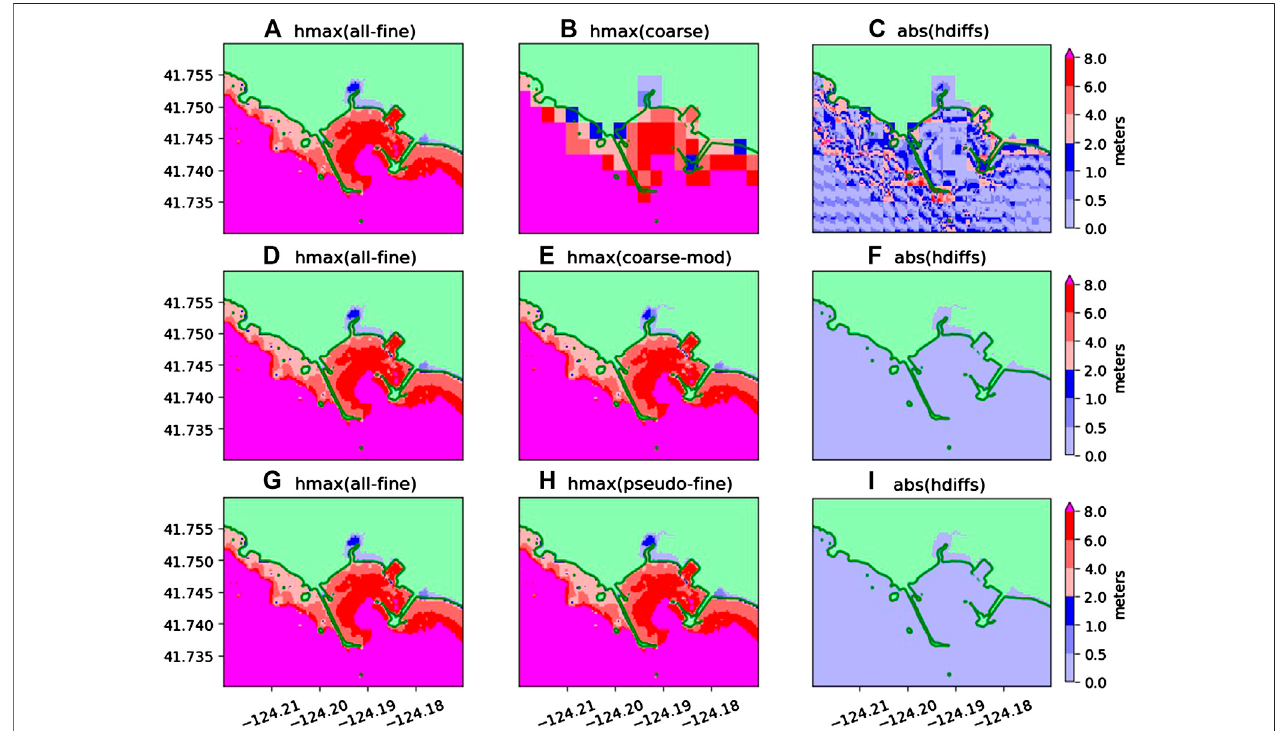
FIGURE8 | Sampleresults forrealization 1,999 at Crescent City, where the tsunami was small. Panels as described in Figure 5 . Purple isabove 8 mand Green is land not inundated.